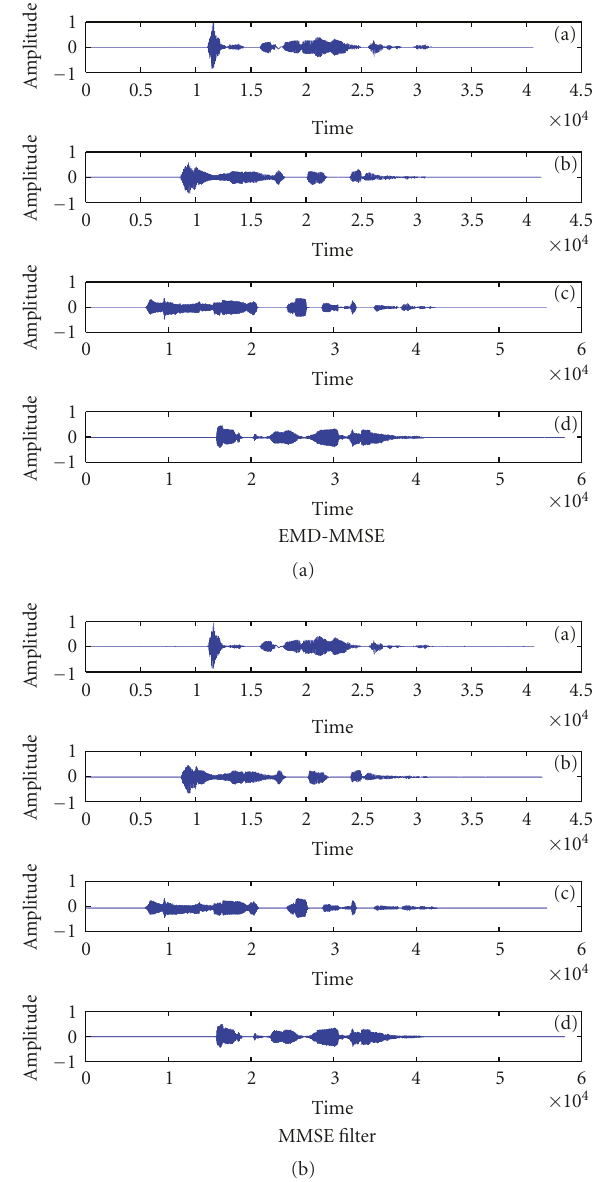
Figure 2: The noisy version of signals “a”, “b”, “c”, and “d”. (SNR = 5dB).